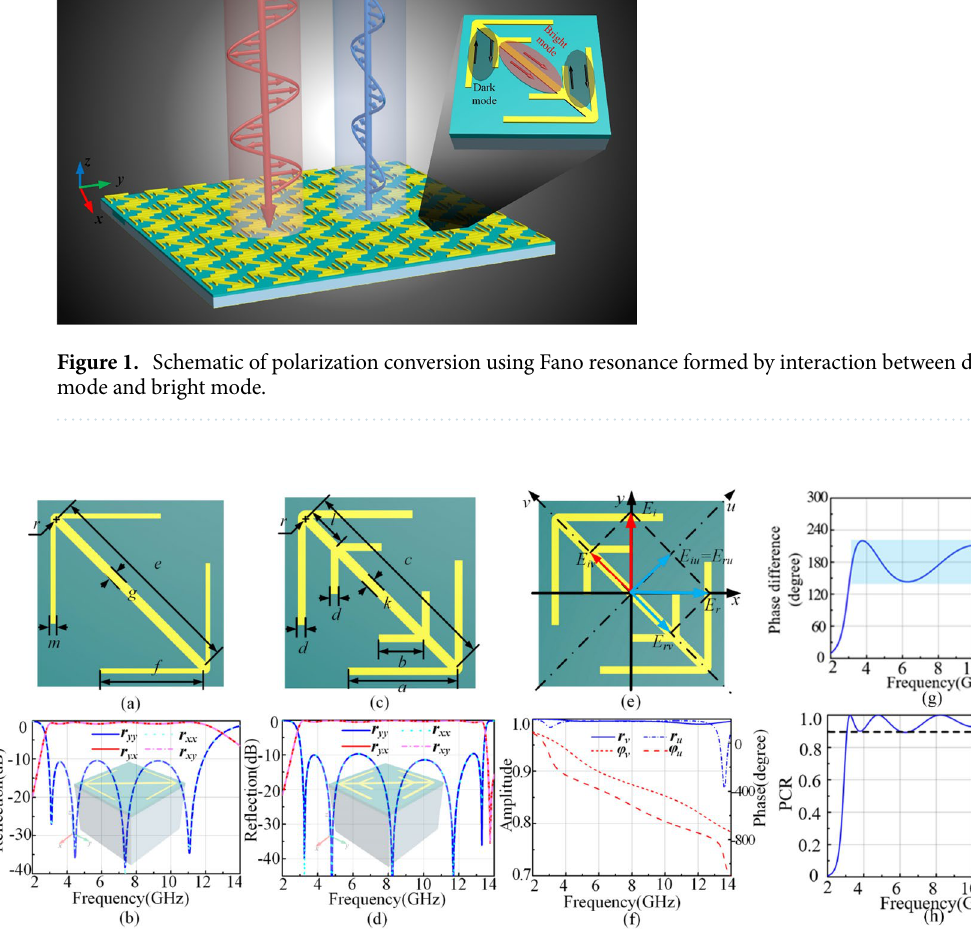
Figure 2. Top view (a) and simulated co- and cross-polarization reflections (b) for unit 1. Top view (c) and simulated co- and cross-polarization reflections (d) for unit 2. (e) is the intuitive image of y -polarized incident wave rotated to x -polarized reflection wave. (f) The reflection amplitudes and phases of unit 2 for u - and v -polarized waves. (g) The phase difference between u - and v -polarized waves. (h) The simulated PCR versus frequency under normal